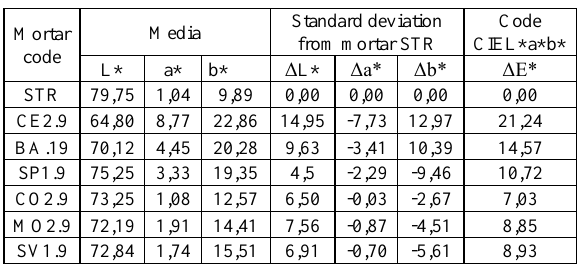
Table 7. Spectrophotometry: comparison between earth mortars and STR mortar. L*: Brightness indicator, a*: red and green axis colour indicator, b*: yellow-blue axis colour indicator. Produced by the authors.